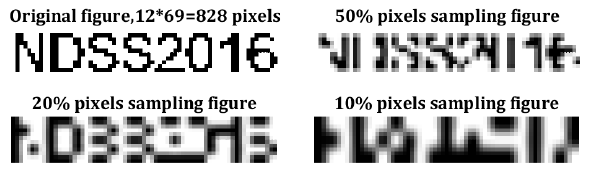
Figure 15. Image recovery result based on different amounts of pixels.